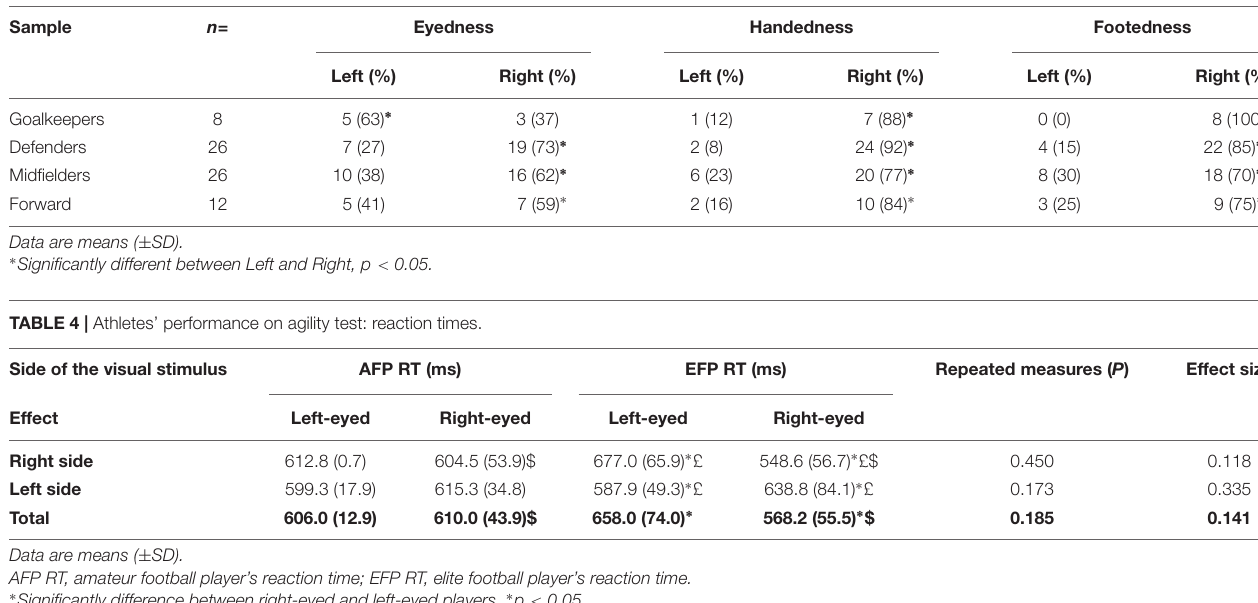
TABLE 5 | Athletes’ performances on agility test: movement times. Side of the rotation AFP MT (s) EFP MT (s) Repeated measures ( P ) Left footed Right footed Left footed Right footed Right rotation